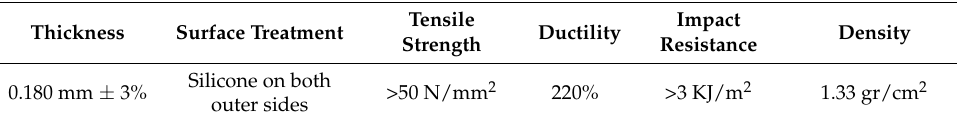
Table 1. Properties of PET